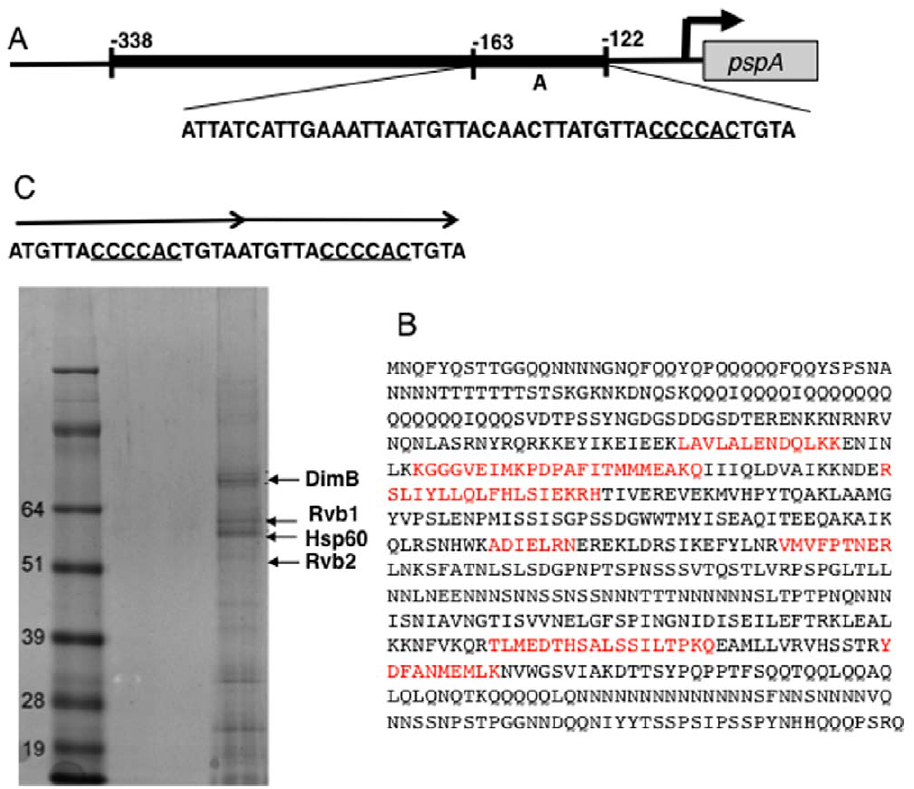
Figure 1. Identification of proteins that bind to the pspA promoter. A representation of the minimal promoter sequence required for pspA expression (thick line) showing the sequence of the region used in affinity chromatography, with a proposed DimB binding site underlined. (B) The combined peptide coverage for DimB in the two different purifications, described in Table 1. is shown in red. (C) Identification of proteins bound to a 16nt tandem dimer containing the proposed DimB site. Only those proteins with a deducible function are indicated and their scores in the mass spectrometry analysis are presented in Table 1.